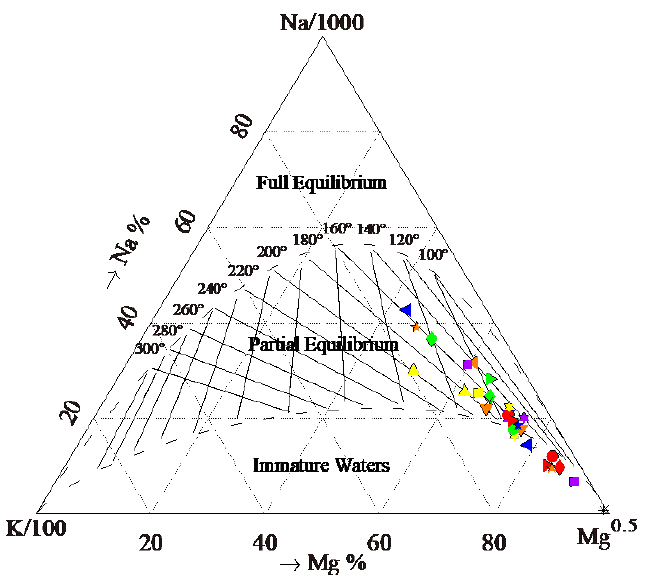
Figure 6. Na-K-Mg ternary diagram of the sampled thermal springs. Table 2. Apparent equilibrium temperatures computed through multi-geothermometers for the samples collected from the thermal springs of Fujian.